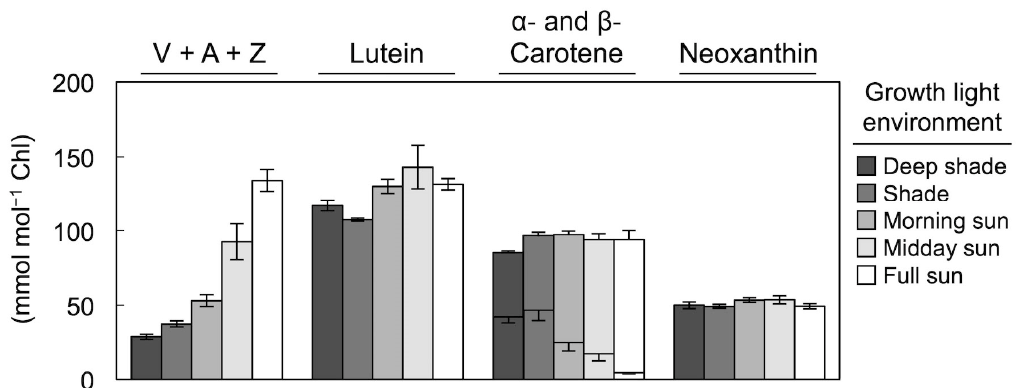
Figure 2. Levels of the primary carotenoids (relative to chlorophyll) present in leaves of 19 species growing in a subtropical rainforest (Dorrigo National Park, New South Wales, Australia) across five light environments from deep shade to full sunlight. Plants growing in Deep shade were never exposed to direct sunlight, those in Shade likely experienced brief periods of high light (sunflecks), those that received Morning or Midday sun were growing where gaps in the canopy permitted direct sunlight to penetrate for longer periods of time, and the most exposed category of plants (Full sun) was at the northern edge of the forest or in the upper canopy where the plants received full sunlight throughout the day. The three carotenoids of the xanthophyll cycle (violaxanthin, antheraxanthin, and zeaxanthin) were pooled together (V + A + Z), as were α -carotene (lower portion of each column) and β -carotene (upper portion of each column). Means ± standard errors are shown. For Deep shade, n = leaves from 10 plants from among seven species. For Shade, n = leaves from 12 plants from among eight species. For Morning sun, n = leaves from seven species. For Midday sun, n = leaves from 4 plants from among three species. For Full sun, n = leaves from 8 plants from among six species. Data from Logan et al. [25].